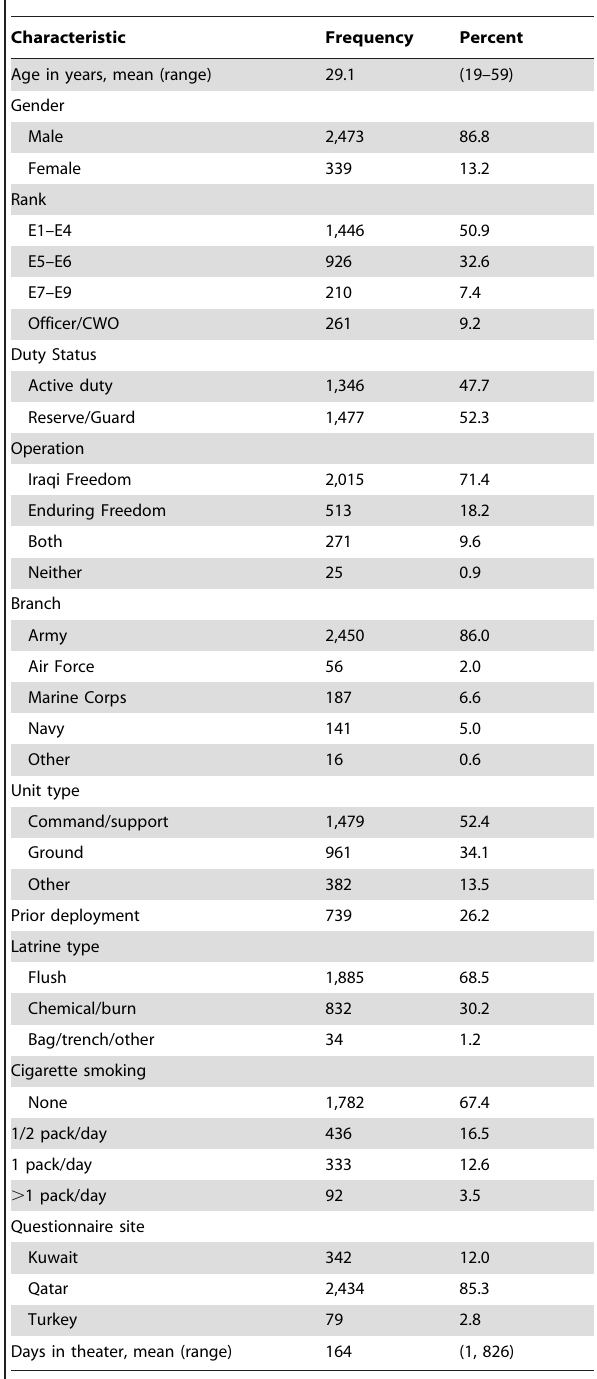
Table 1. Demographic characteristics of 2,872 deployed